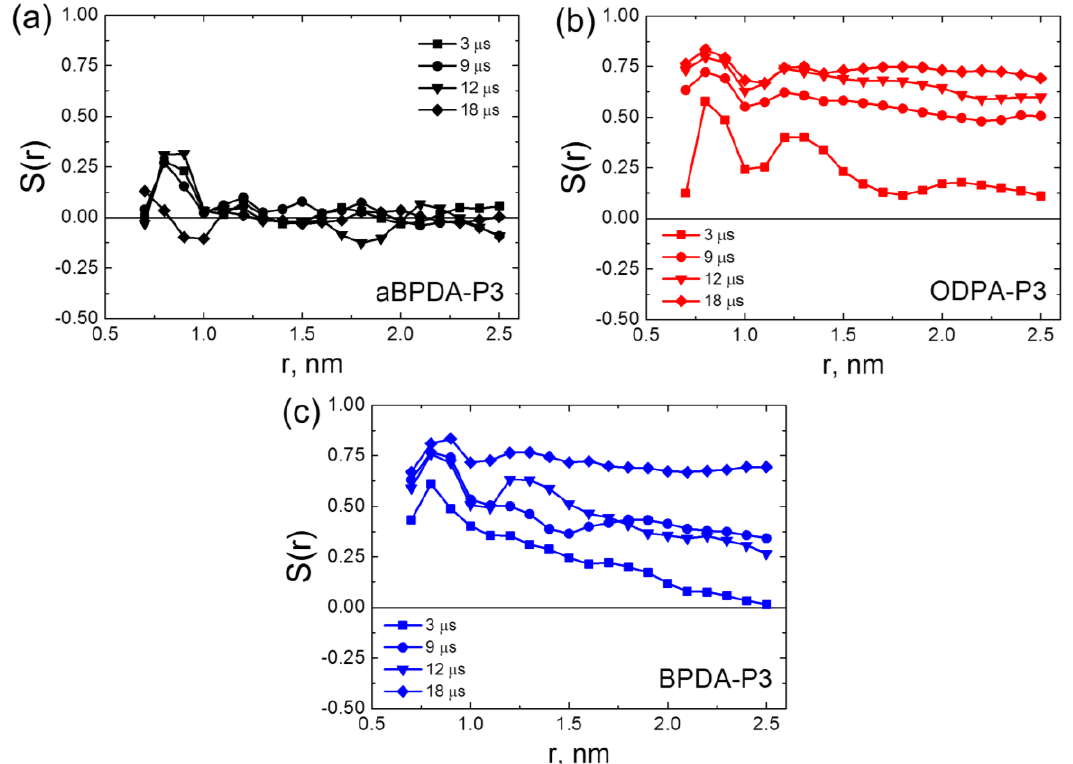
Figure 2. The order parameter S ( r ) for the orientation angle θ of the polymer-chain planar moieties relative to the single-walled carbon nanotube (SWCNT) axis in nanocomposites based on aBPDA-P3 ( a ), ODPA-P3 ( b ), and BPDA-P3 ( c ) at T = 600 K as functions of the distance from the nanotube axis after different simulation times shown in the legends. The results for the ODPA-P3 and aBPDA-P3 polyimides (PIs) calculated after 3 μs of simulation are taken for comparison from our previous study [30].